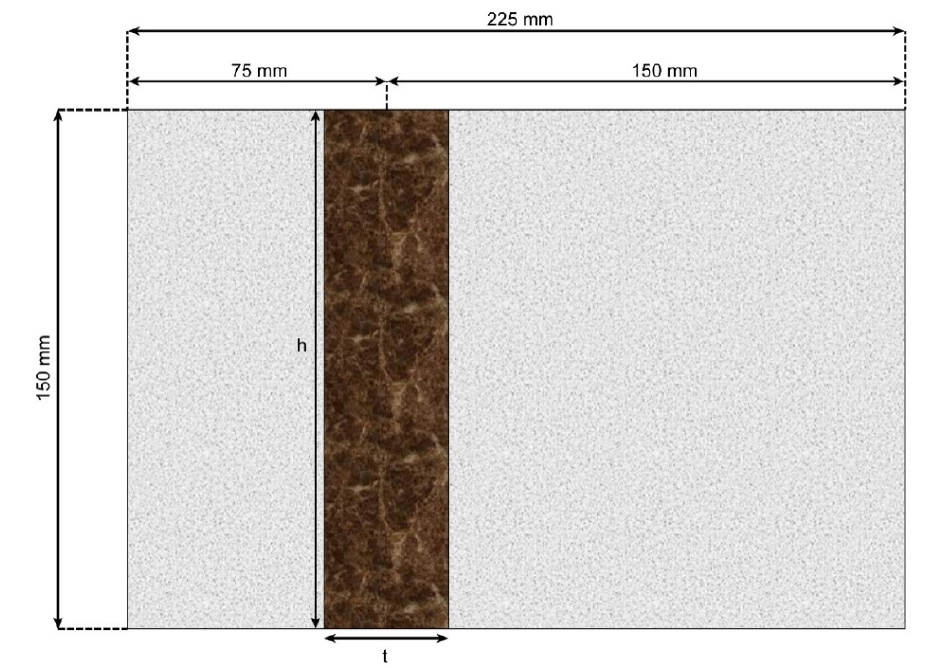
Figure 6. b-b’section of specimen.